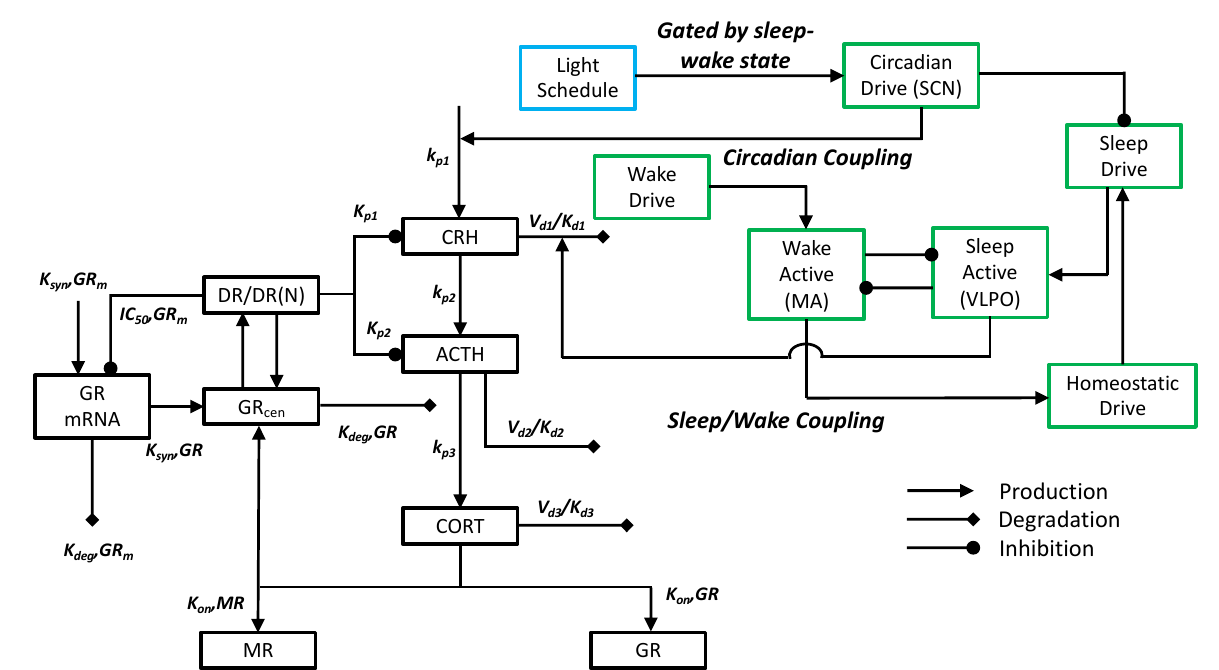
Figure 1. Schematic of our mathematical model: a physiologically based mathematical model of sleep/wake regulation coupled to a semi-mechanistic mathematical model of the circadian dynamics of the HPA axis. The physiologically based model of sleep/wake regulation accounts for the interactions between sleep-active VLPO (ventrolateral preoptic) neuronal population and the wake-active MA (monoaminergic) neuronal population. The homeostatic sleep drive and the wake drive both regulate the firing rates of the VLPO and MA neuronal populations, respectively. The entraining influence of light on the circadian rhythm is gated such that it influences the circadian drive from the SCN (suprachiasmatic nucleus) only if light exposure is present during waking hours. The circadian drive entrains the HPA axis (CRH, ACTH, cortisol (CORT), and GR-mediated negative feedback), which subsequently regulates the engagement of downstream, tissue glucocorticoid (GR) and mineralocorticoid (MR) receptors.